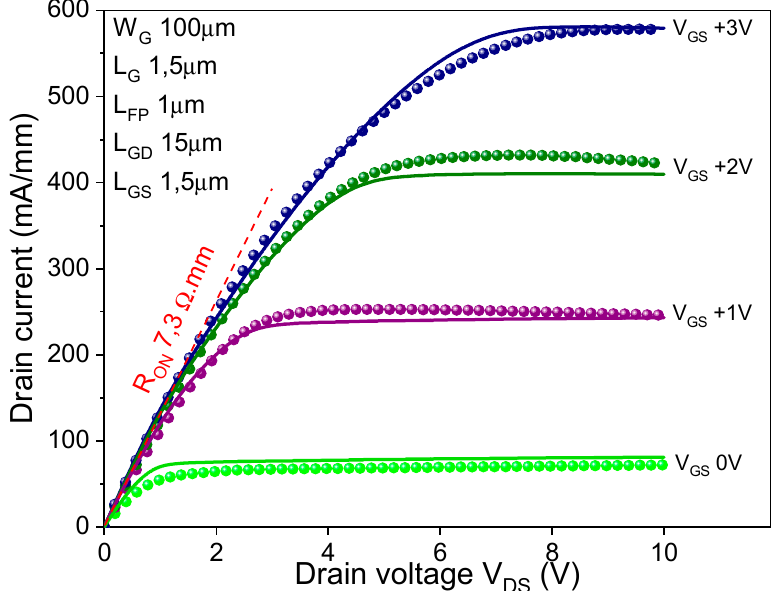
Figure 2. Experimental (doted) and simulated (line) output characteristics of the device for V GS from 0 to +3 V.